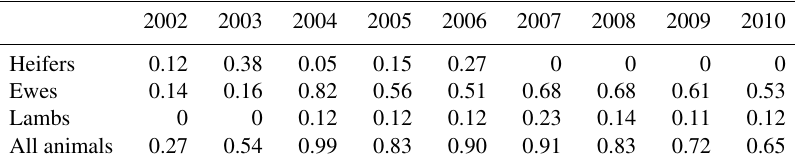
Table 1. Average annual stocking rates (LSU ∗ ha − 1 a − 1